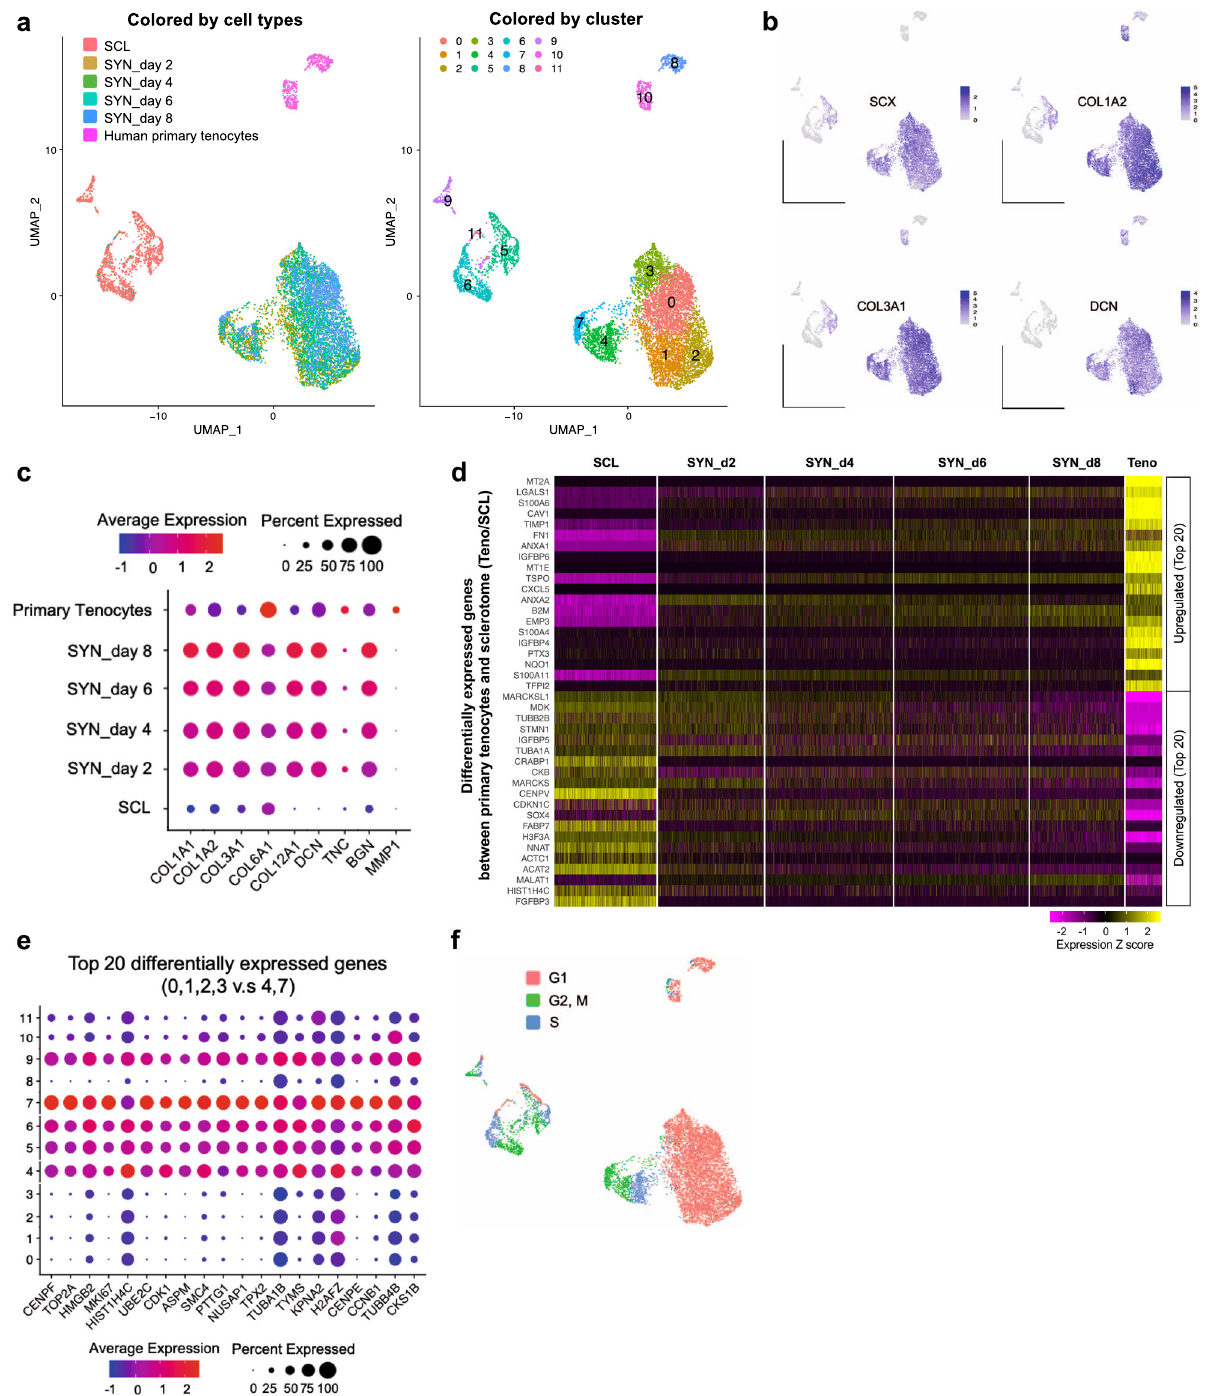
Fig. 3 Characterization of iPSC-derived syndetome. a , b UMAP for iPSC-derived sclerotome, syndetome (days 2, 4, 6, 8), and primary human tenocytes revealed 12 unique cell clusters (labeled 0 – 11) ( a ). Representative markers for syndetome and tenocytes are shown ( b ). c Dot plot showing the expression of tenocyte-speci fi c extracellular matrix factors expressed in sclerotome, syndetome, and primary tenocytes. d Heatmap showing the top 40 differentially expressed genes in primary human tenocytes vs. iPSC-derived sclerotome. Gene expression in iPSC-derived syndetome indicates the transcriptional similarity of iPSC-derived syndetome and primary human tenocytes. Teno, primary human tenocytes. e , f Characteristics of each syndetome cluster were assessed based on a dot plot showing the top 20 differentially expressed genes in each cluster [0,1,2,3] and [4,7] ( e ), and by cell cycle analysis ( f rats. In contrast, untreated rats still showed dorsal fl exion even at four weeks (Fig. 4d, right panel), suggesting that the regenerated Achilles tendon of iPSC-tenocytes rats could transmit the output from the gastrocnemius muscle to the bone better than that of untreated rats. These observations imply that regenerated Achilles